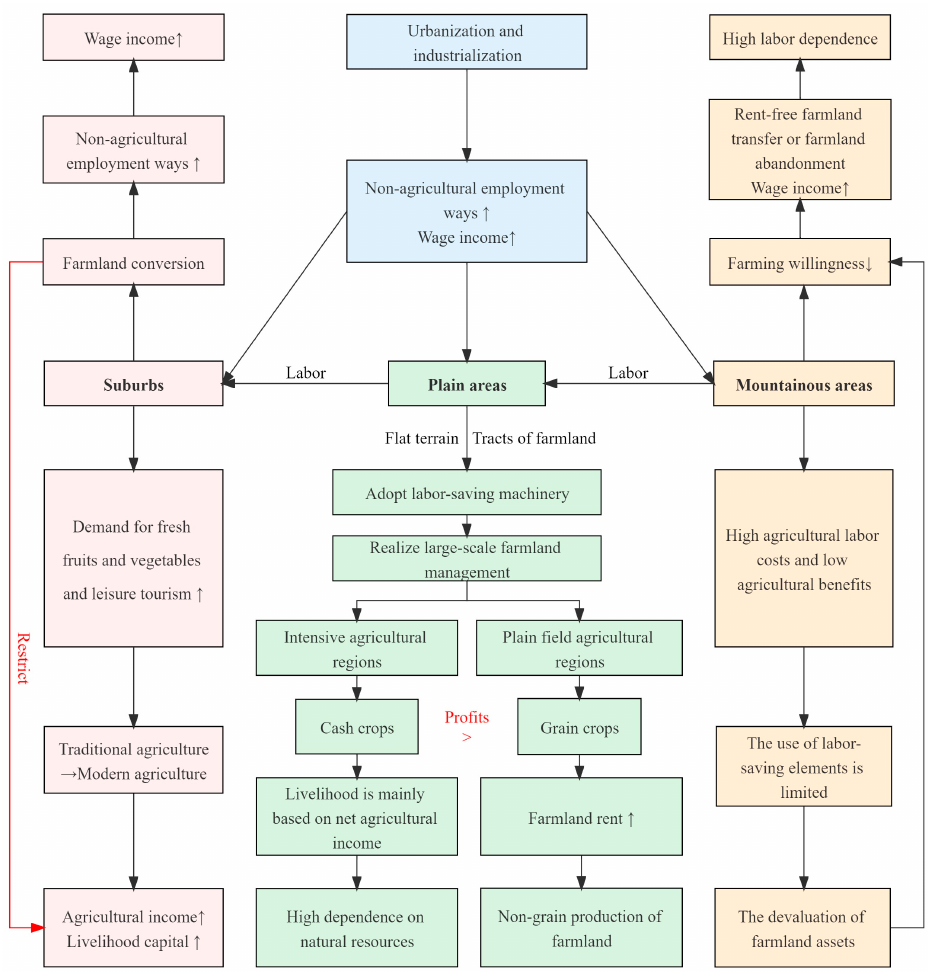
Figure 5. Evolution of rural livelihood differences in different agricultural regions.